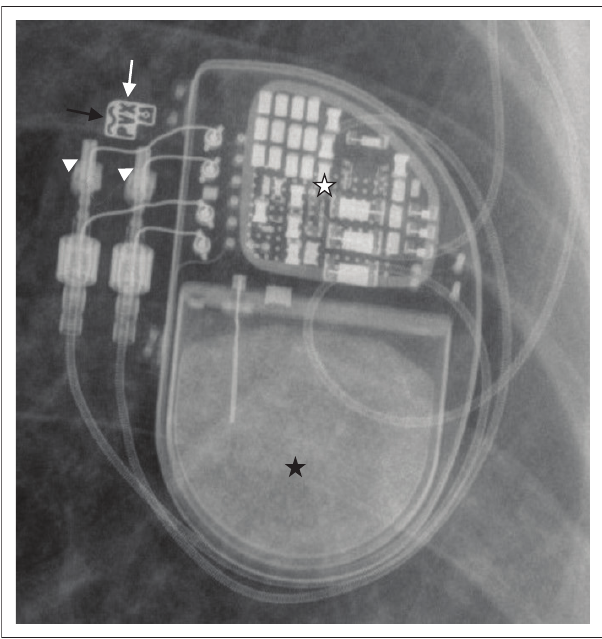
FIGURE 1: Basic components of a cardiovascular implantable electronic device (CIED) generator include the battery (black star), the circuitry (white star) and the terminal connector ports (arrow heads). The pacemaker generator contains the manufacturer logo (white arrow). This pacemaker is MRI conditional as indicated by the curvilinear line (black arrow) near the manufacturer logo.